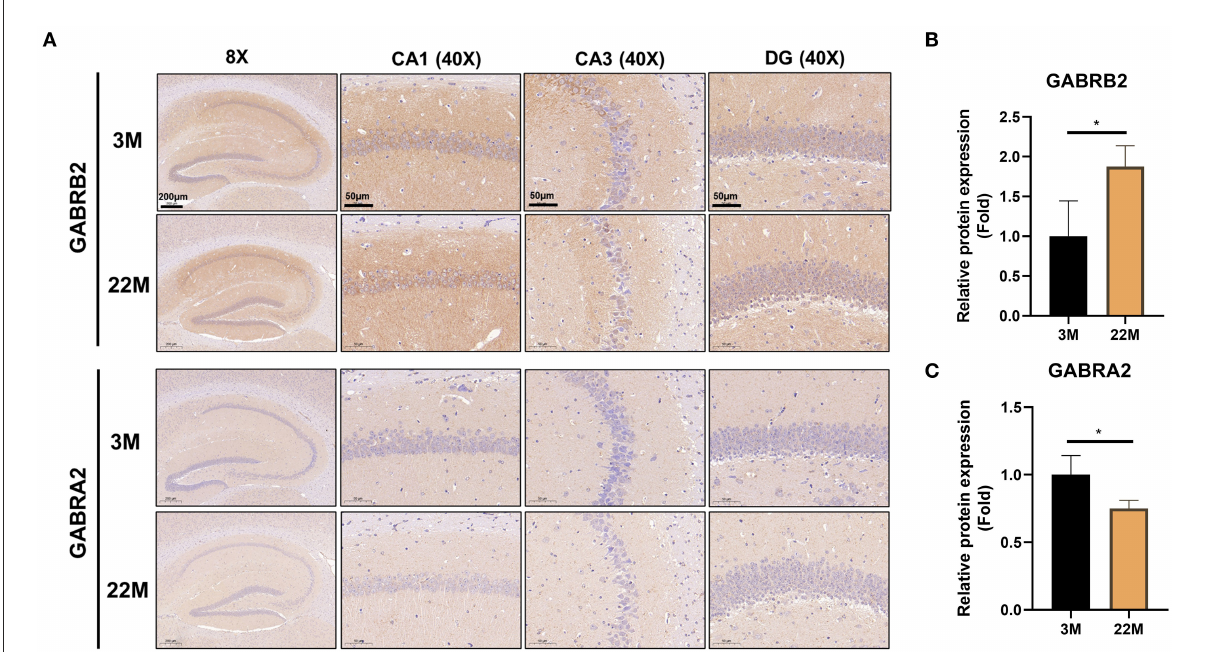
FIGURE4 Validation of GABRB2 and GABRA2 expression by IHC of hippocampus in aging mice. (A) IHC of GABRB2 and GABRA2 in the hippocampus between 3M and 22M group. The magnifications and scale bars were shown in (A) . (B,C) Relative expressions of GABRB2 and GABRA2 were calculated by IHC. Data were represented as mean ± SD and were analyzed by Student t -test. * P <